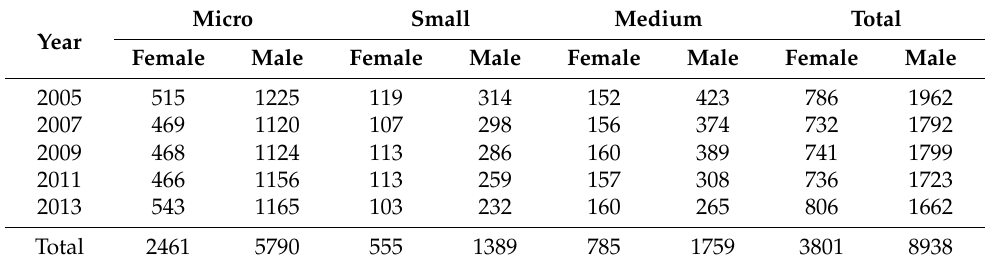
Table 3. Distribution of male-led and female-led firms by firm size.